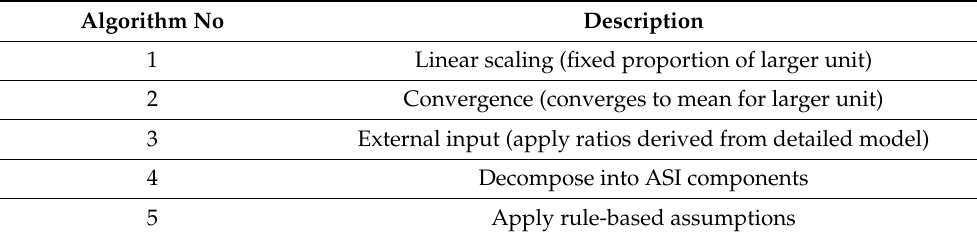
Table 2. Summary of